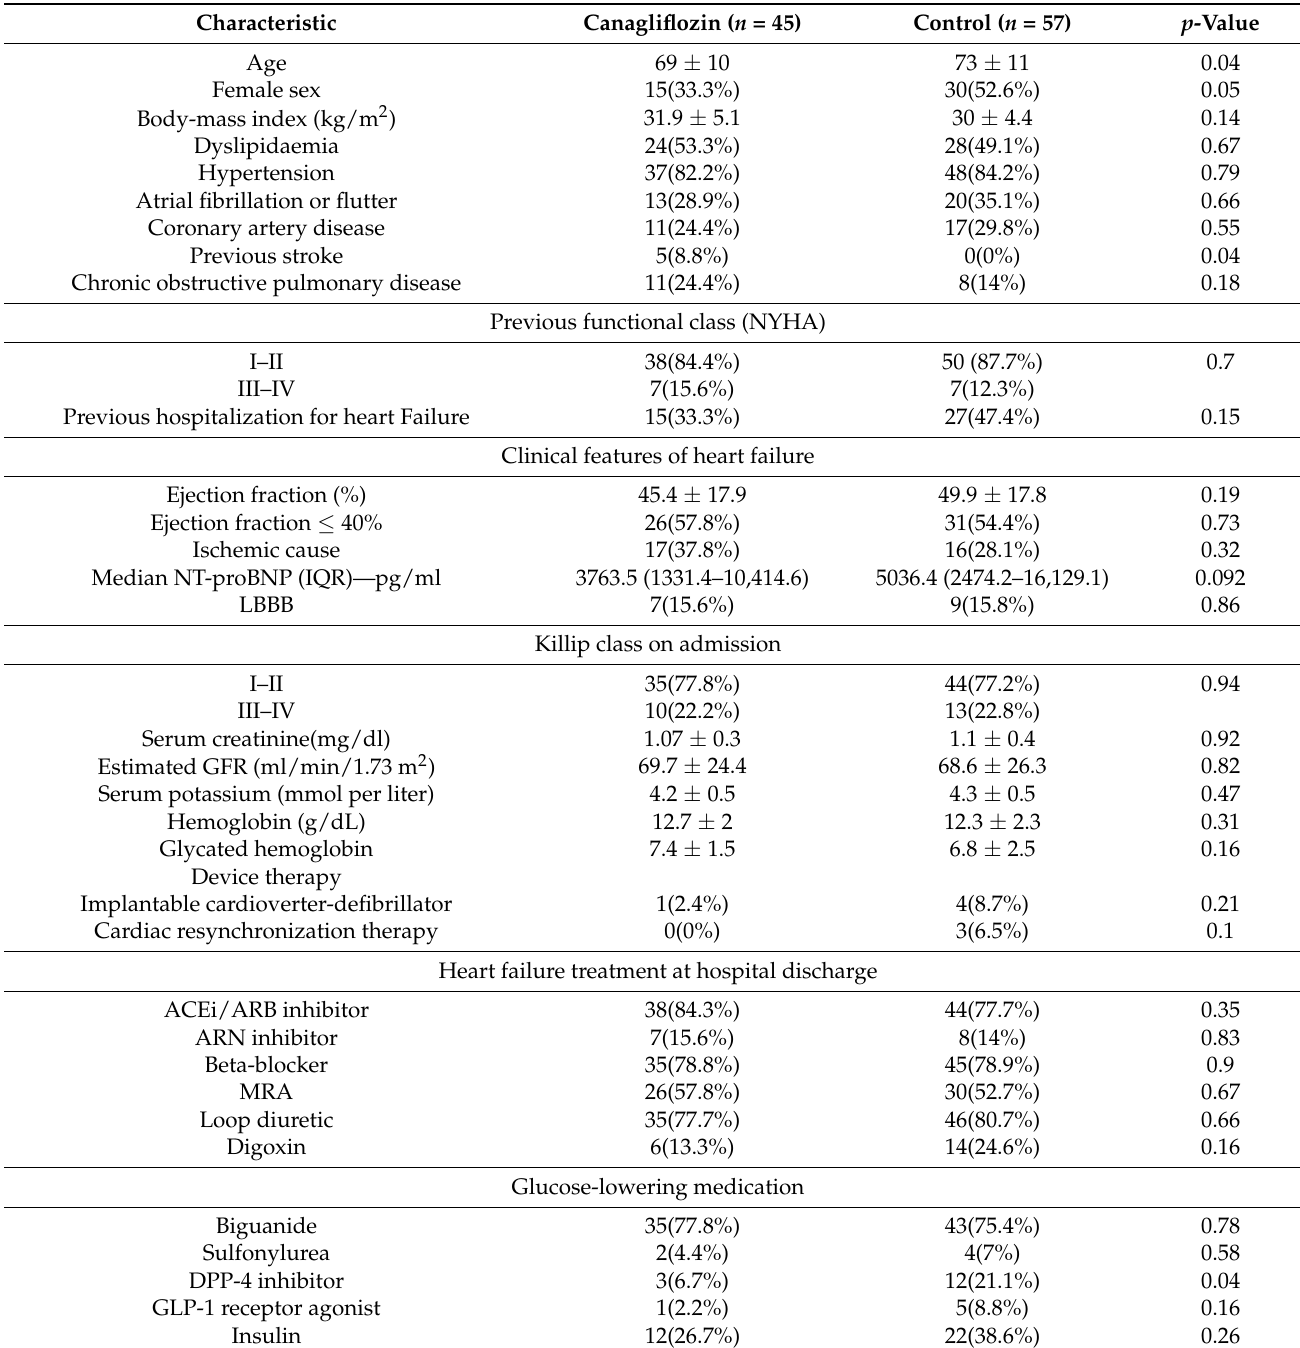
Table 1. Baseline